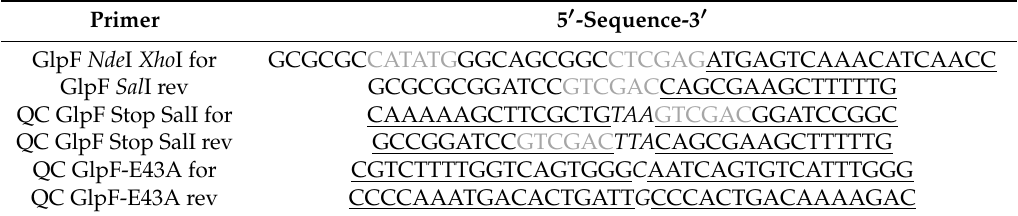
Table 2. Oligonucleotides used in this study. glpF sequences are underlined and sequences recognized by restriction enzymes are highlighted in gray. Mutated and added bases are highlighted in bold. Primer 5 (cid:48) -Sequence-3